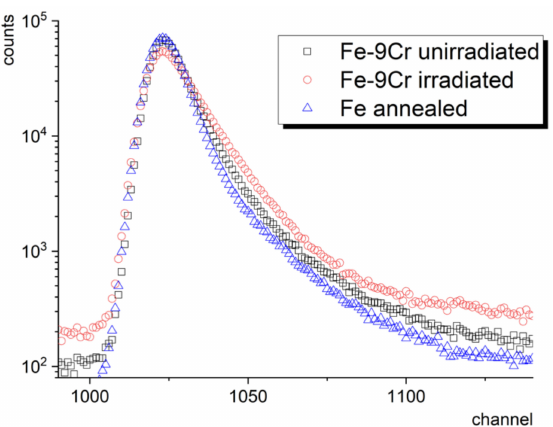
Figure 4. Lifetime spectrum of defect-free annealed Fe, together with the spectrum of Fe–9Cr steel before and after exposure to radiation environment of spallation neutron source